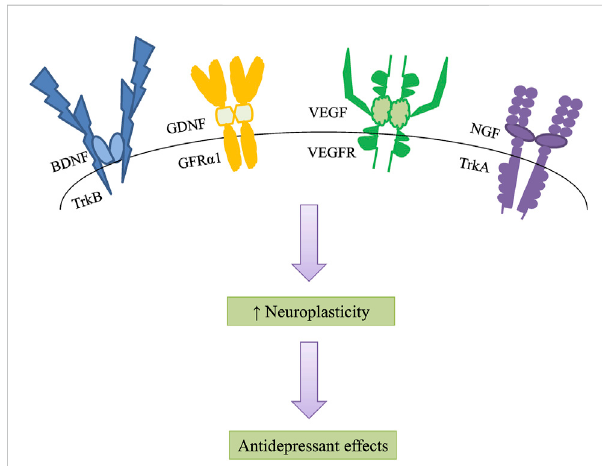
FIGURE 1 Neurotrophic factors increase neuroplasticity, especially synaptic plasticity, neurotransmission, and neuronal survival, growth, and differentiation. An increase in neuroplasticity is likely to induce antidepressant effects. BDNF, brain-derived neurotrophic factor; TrkB, tropomyosin-related kinase receptor B; GDNF, glial cell line- derived neurotrophic factor; GFR α 1, GDNF-family receptor- α 1; VEGF, vascular endothelial growth factor; VEGFR, vascular endothelial